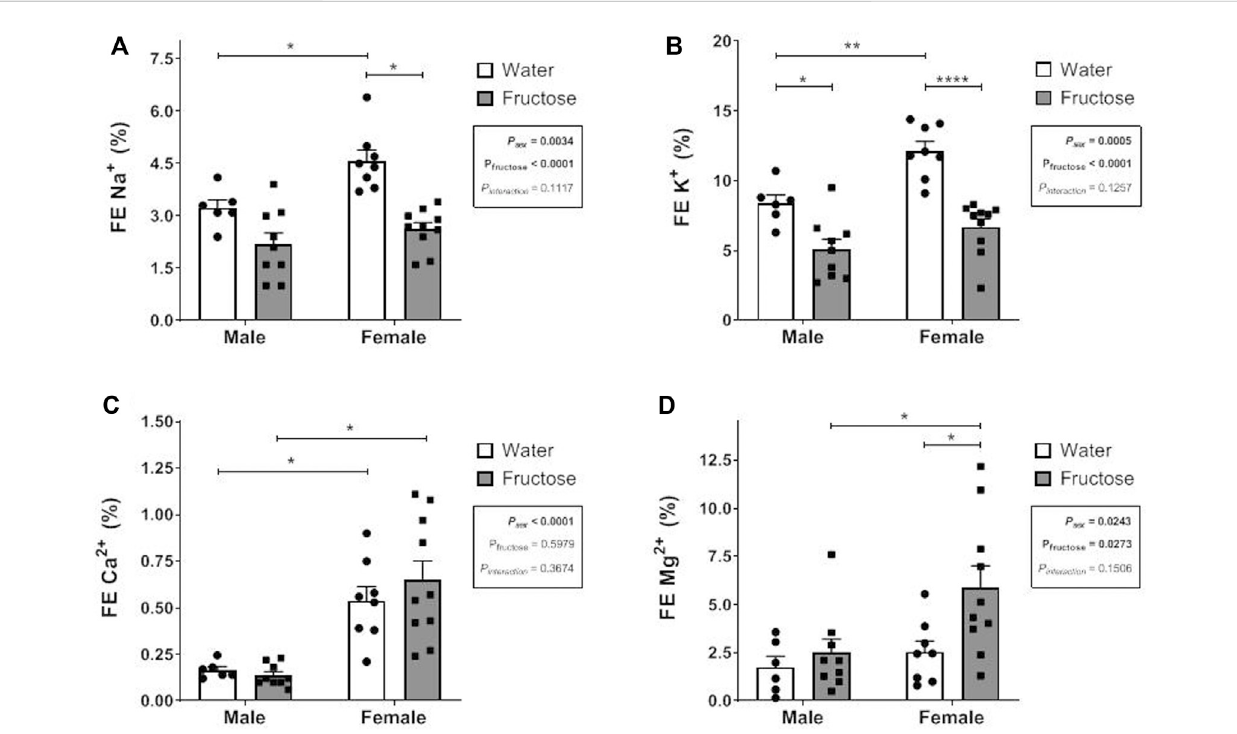
Fractional Excretion (FE) of sodium (A) , potassium (B) , calcium (C) and magnesium (D) in male and female rats that received or not fructose drinking solution. Values are mean ± standard error. Two-way ANOVA followed by Tukey ’ s post hoc test, * p ≤ 0.05; ** p ≤ 0.01; **** p ≤ 0.001, 6-10 animals per